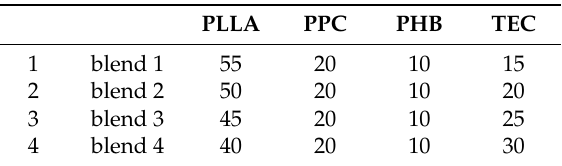
Table 1. The blends prepared. PLLA: polylactic acid; PPC: polypropylene carbonate; PHB: poly (butylene carbonate); TEC: triethyl citrate.